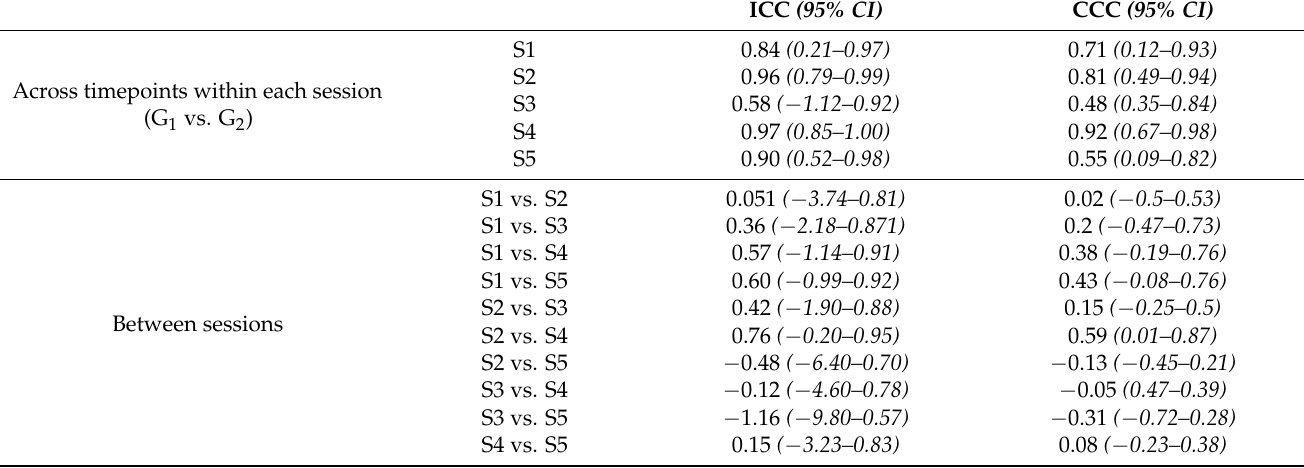
Table 3. ICCs and CCCs used in the regression analysis for Study 1. In parenthesis the 95% confidence interval. G 1 corresponds to the median MEP at 10, 20, 30 min and G 2 corresponds to the median MEP at 40, 50, 60